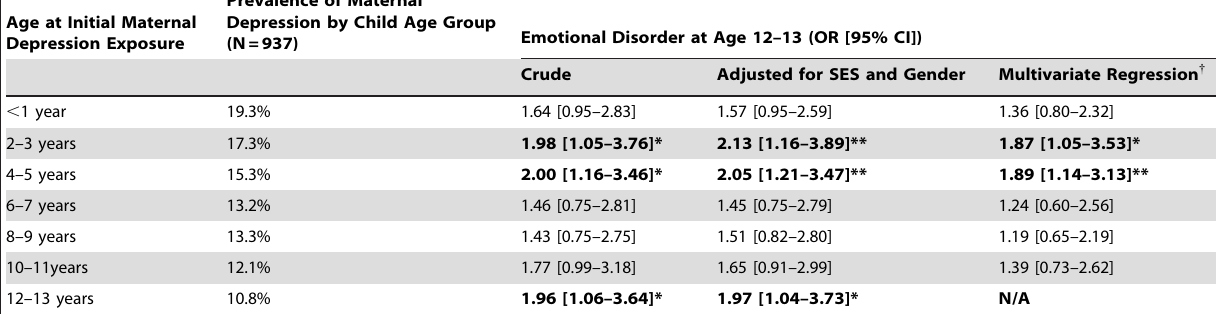
Table 2. Association between Adolescent Emotional Disorder and Initial Exposure to Maternal Depression, by Two-Year